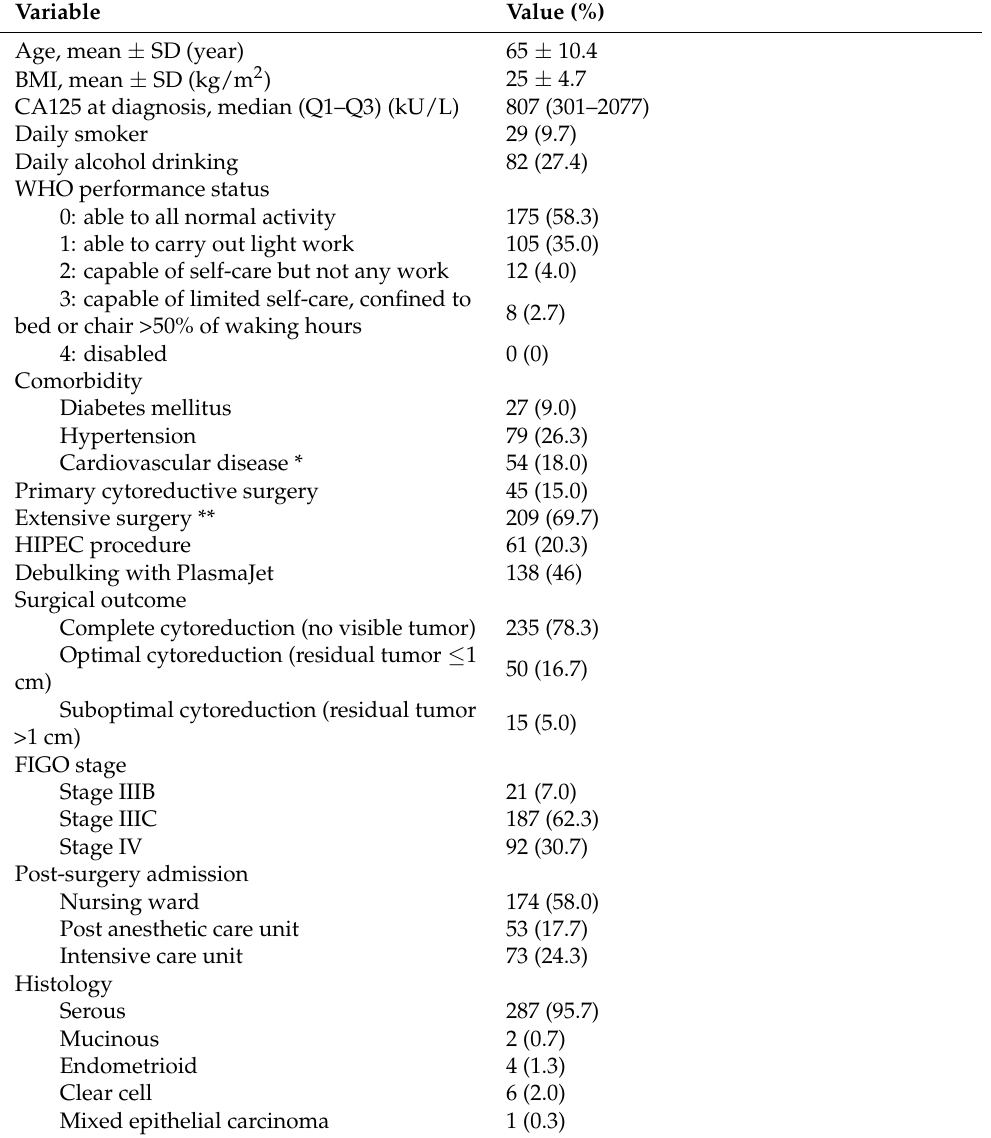
Table 1. Baseline characteristics ( N =